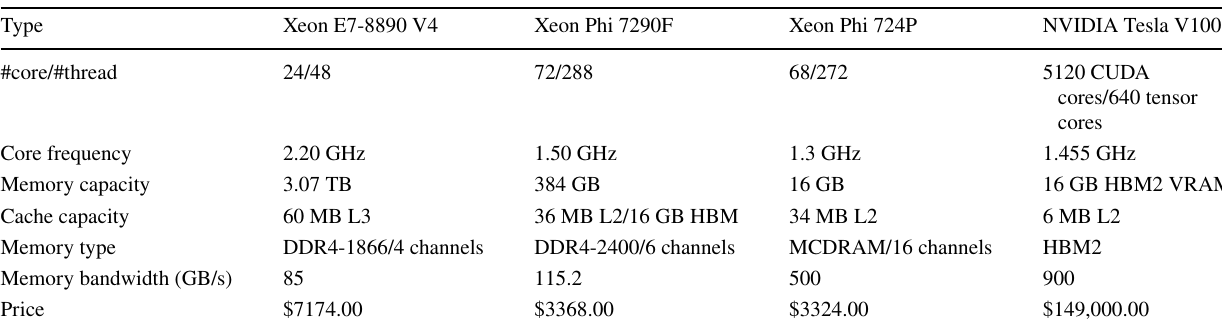
Table 1 Processor characters